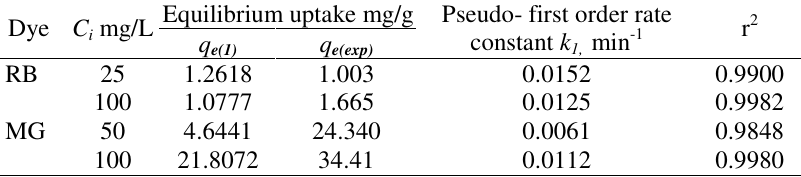
Table 3. Pseudo-first order parameters for adsorption of dyes at 30 °